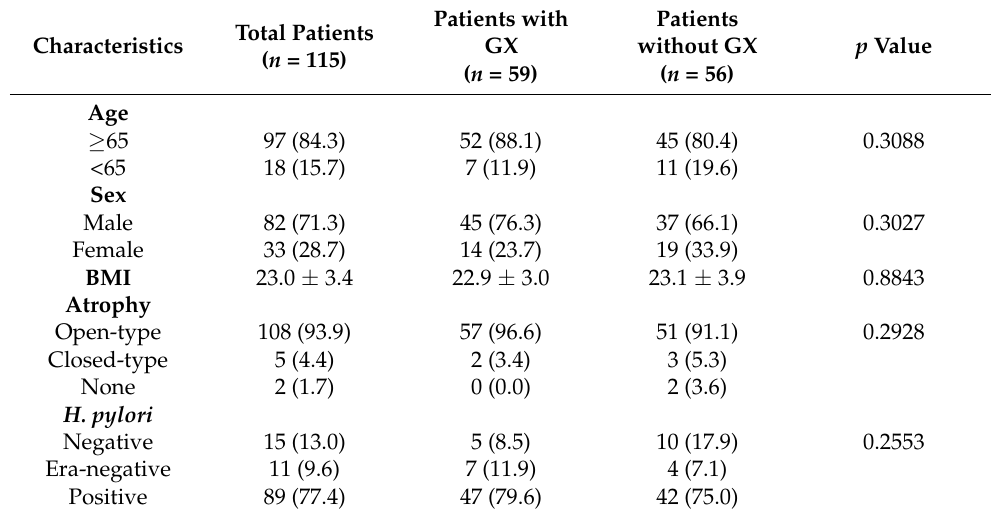
Table 1. Comparison of clinical features between patients with and without gastric xanthelasma.